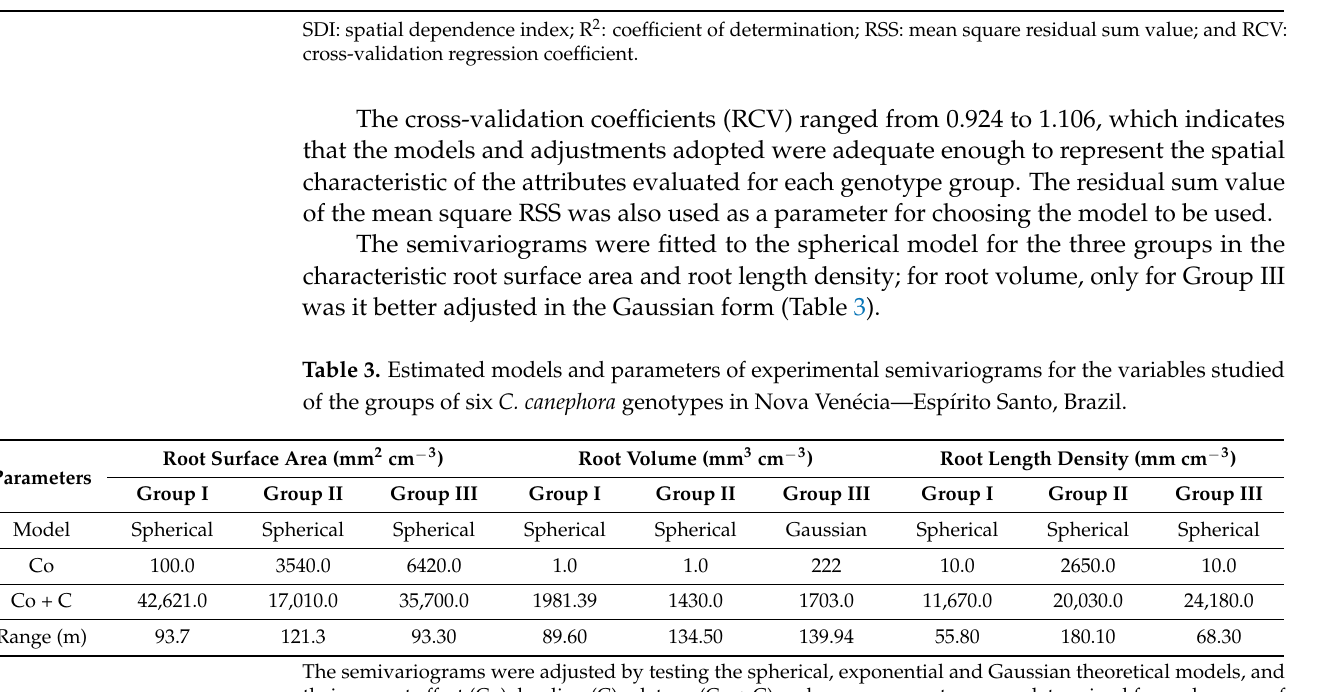
Table 2. Estimated parameters of experimental semivariograms for the studied variables of the groups of six genotypes of C. canephora in Nova Venécia—Espírito Santo, Brazil.